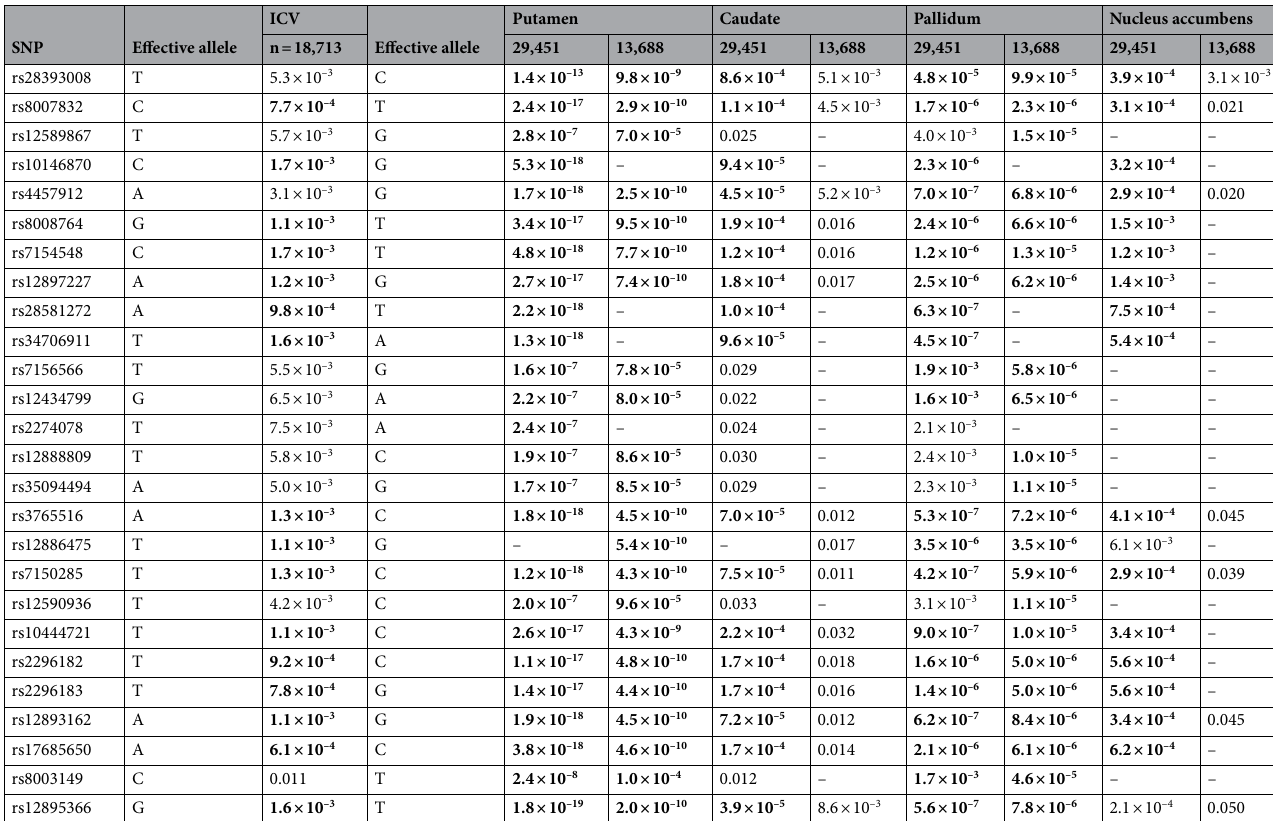
Table 3. p values for associations between schizophrenia-risk SNPs and ICV and GMVs of basal ganglia. “– “, p > 0.05. The bold p values correspond to q < 0.05. ICV, total intracranial volume; GMV, gray matter